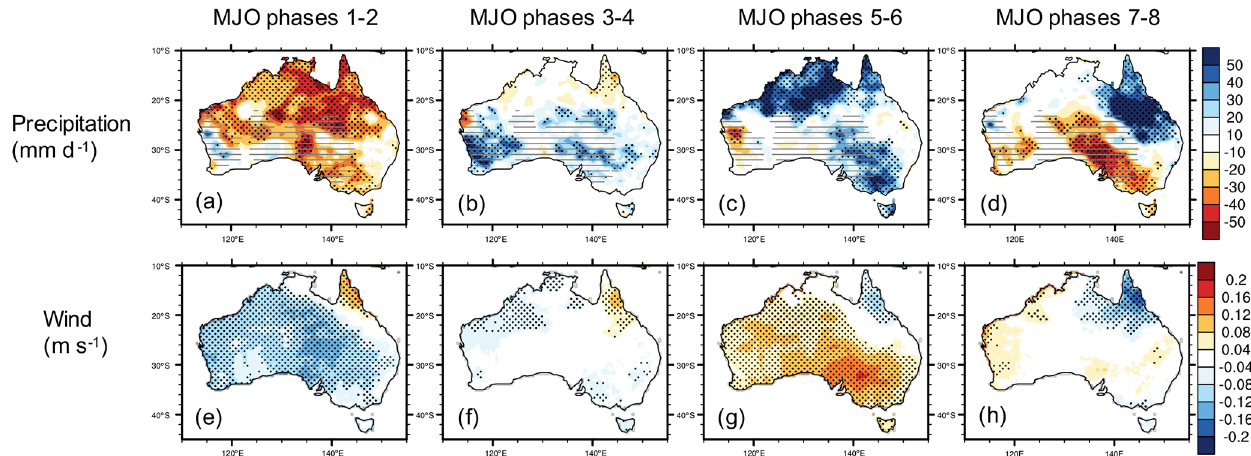
Figure 12. Mean anomalies in daily precipitation and surface wind speed by MJO phase in September–February. Figure elements are the same as in Fig. 11a–h. Grey dashes indicates areas with seasonal mean rainfall less than 1mmd − 1